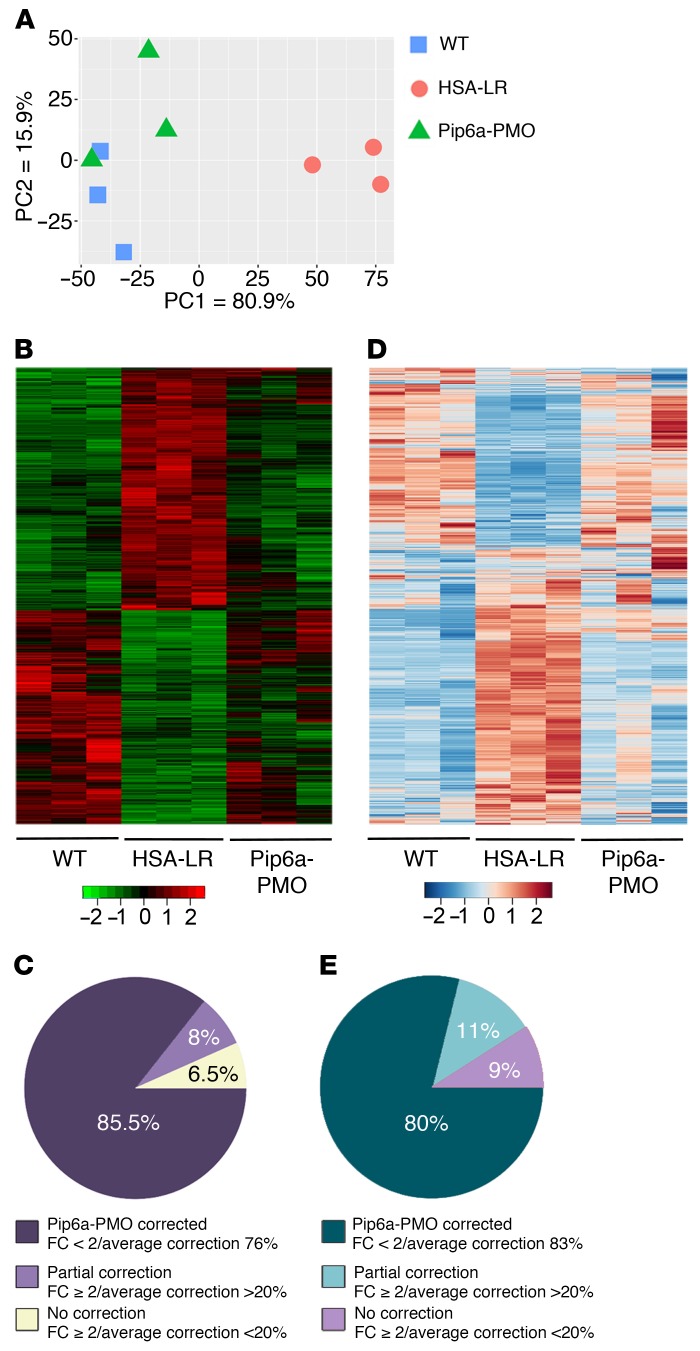
Treatment with Pip6a-PMO normalizes global transcriptome at both expression and splicing levels.Transcriptomic analysis by RNA sequencing was performed on total RNA isolated from gastrocnemius muscles of treated HSA-LR mice compared with HSA-LR and WT mice (n = 3). (A and B) Principal component analysis (A) and heatmap graphic (B) of all significantly expressed transcripts (adj. P < 0.1) reveal a global correction of the gene expression profile with Pip6a-PMO treatment. (C) Global correction of gene expression by Pip6a-PMO treatment (n = 376; FC ≥ 2, adj. P < 0.1): 85.5% of transcripts return to FC < 2 with an average correction index of 76%; 8% of transcripts remain at FC ≥ 2 but with correction index > 20%; 6.5% of transcripts are not corrected. (D) Heatmap graphic of all significant deregulated exon_bin (normalized counts) reveals a global correction of missplicing events with Pip6a-PMO treatment. (E) Overall correction of alternative splicing profiles by Pip6a-PMO treatment (n = 339 splicing events; FC ≥ 2, adj. P < 0.1): 80% of events return to FC < 2 with an average correction index of 83%; 11% remain at FC ≥ 2 but with correction index > 20%; 8% are not corrected.